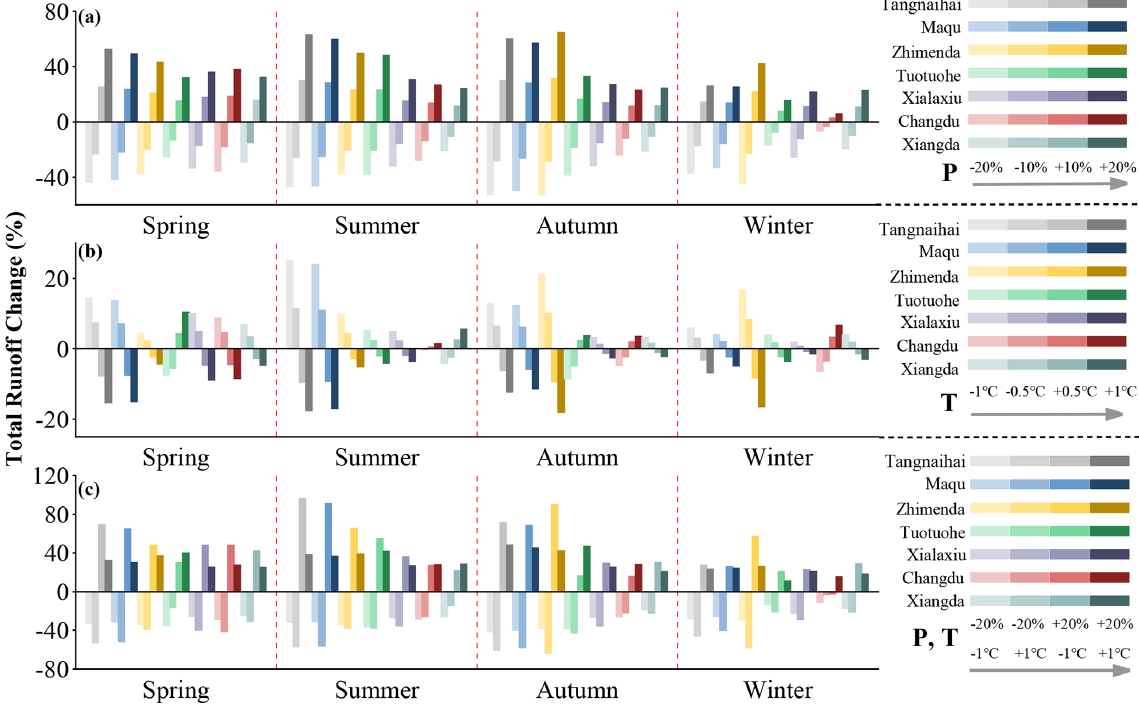
Figure 9. Seasonal percentage change in total runoff relative to the period 1984–2018 under various scenarios for the seven stations. (a) Con- sidering precipitation changes only. (b) Considering temperature changes only. (c) Considering precipitation and temperature changes simul-